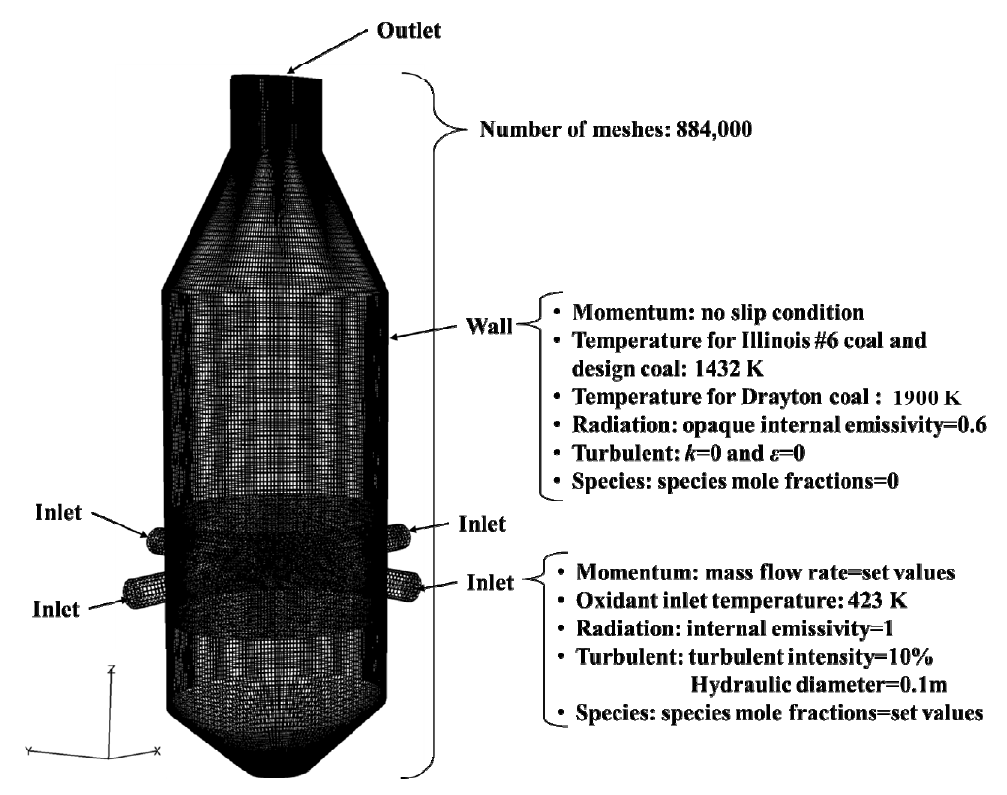
Figure 2. Mesh and boundary